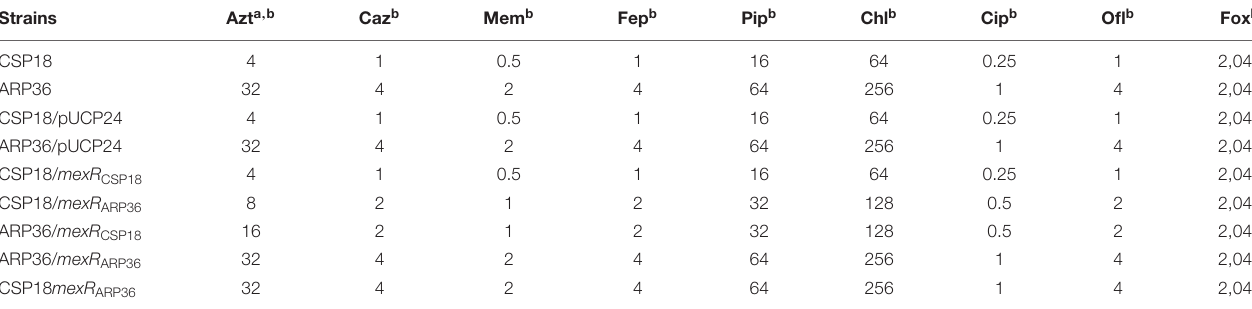
TABLE 1 | MICs ( µ g/ml) of indicated P. aeruginosa strains. Strains